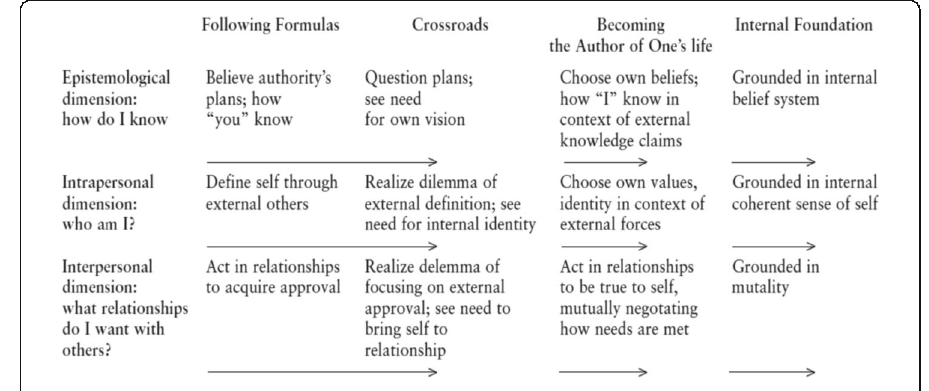
Fig. 1 Self-authorship framework adopted from Baxter Magolda ’ s (2004)